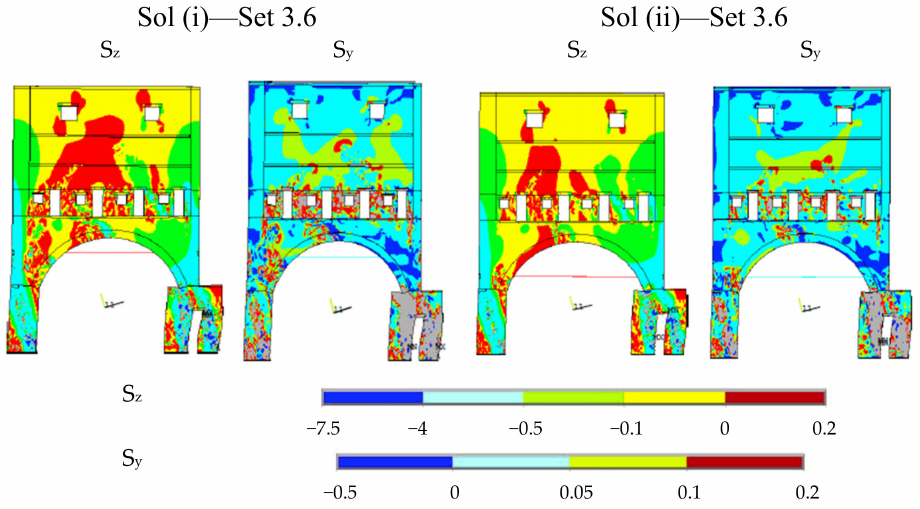
Figure 21. Stress states in [N/mm 2 ] in the two hypotheses of intervention for the Arengario.